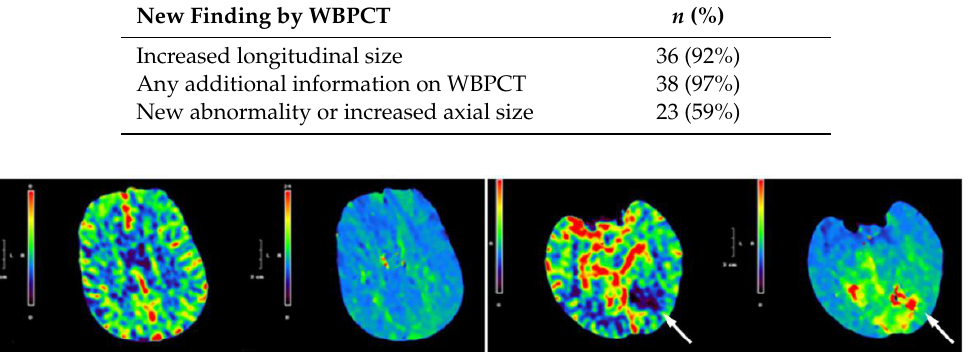
Table 4. Comparison of patients with a new perfusion abnormality detected by WBPCT versus those without new